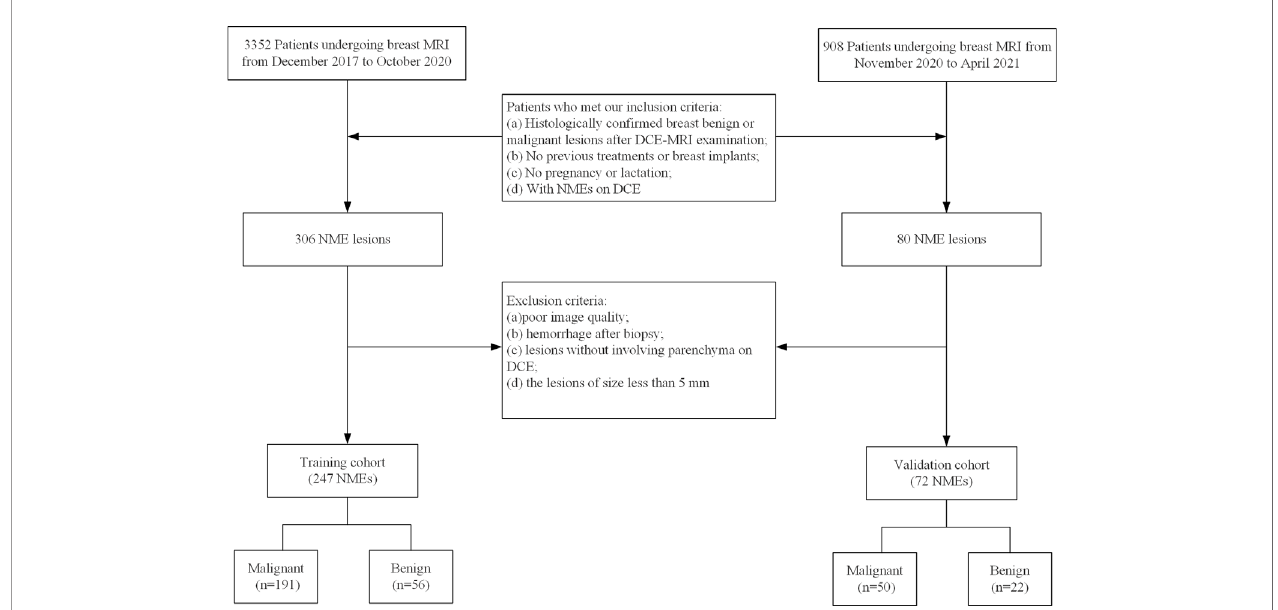
FIGURE 1 | Flowchart of the study population enrollment. NME, non-mass enhancement